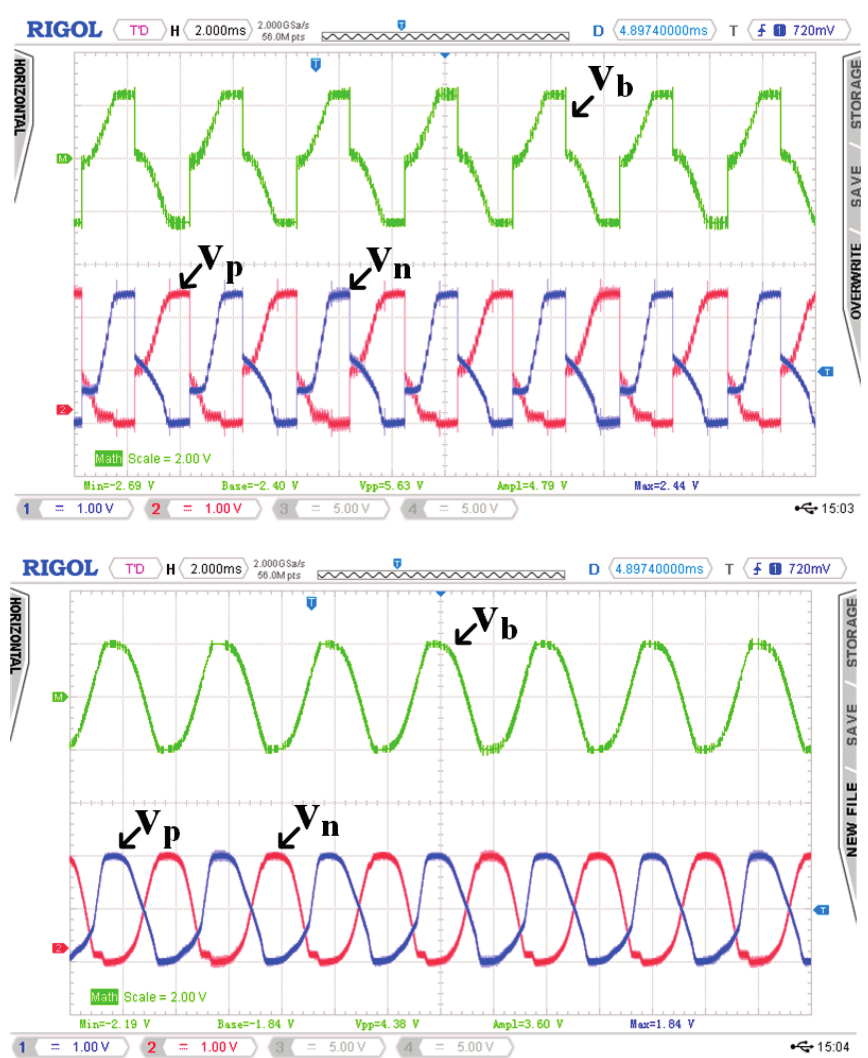
Figure 8. Measured waveforms of the output voltages across PD for the proposed rectifier ( top ) and the full wave bridge rectifier ( bottom